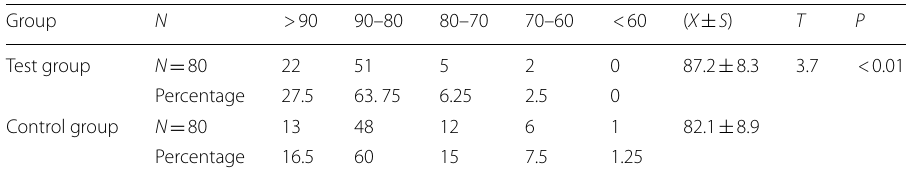
Table 2 Test results comparison results